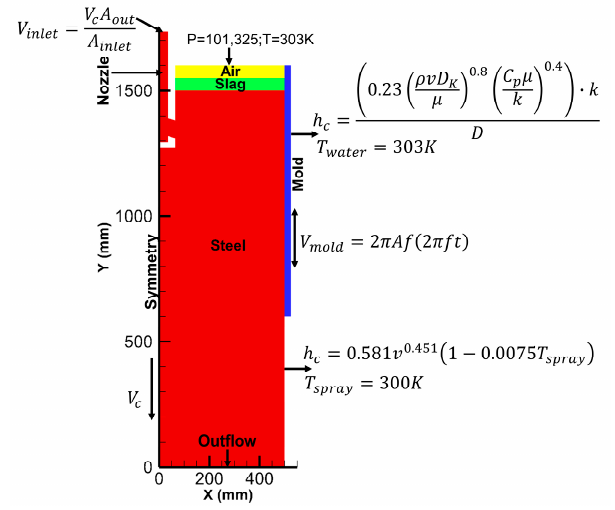
Figure 2. Boundary conditions of model.